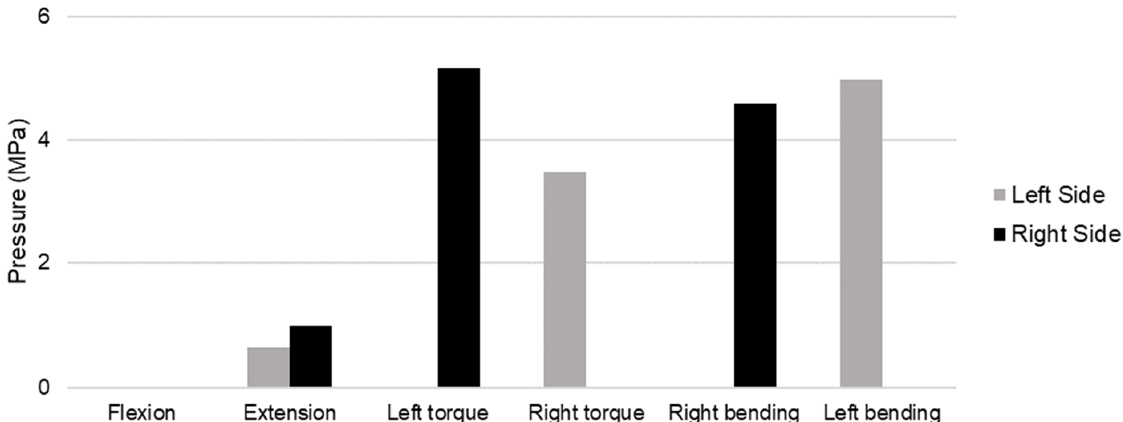
Figure 5. Maximum contact pressure between the opposing facet cartilages in flexion, extension, axial rotation, and lateral bending.